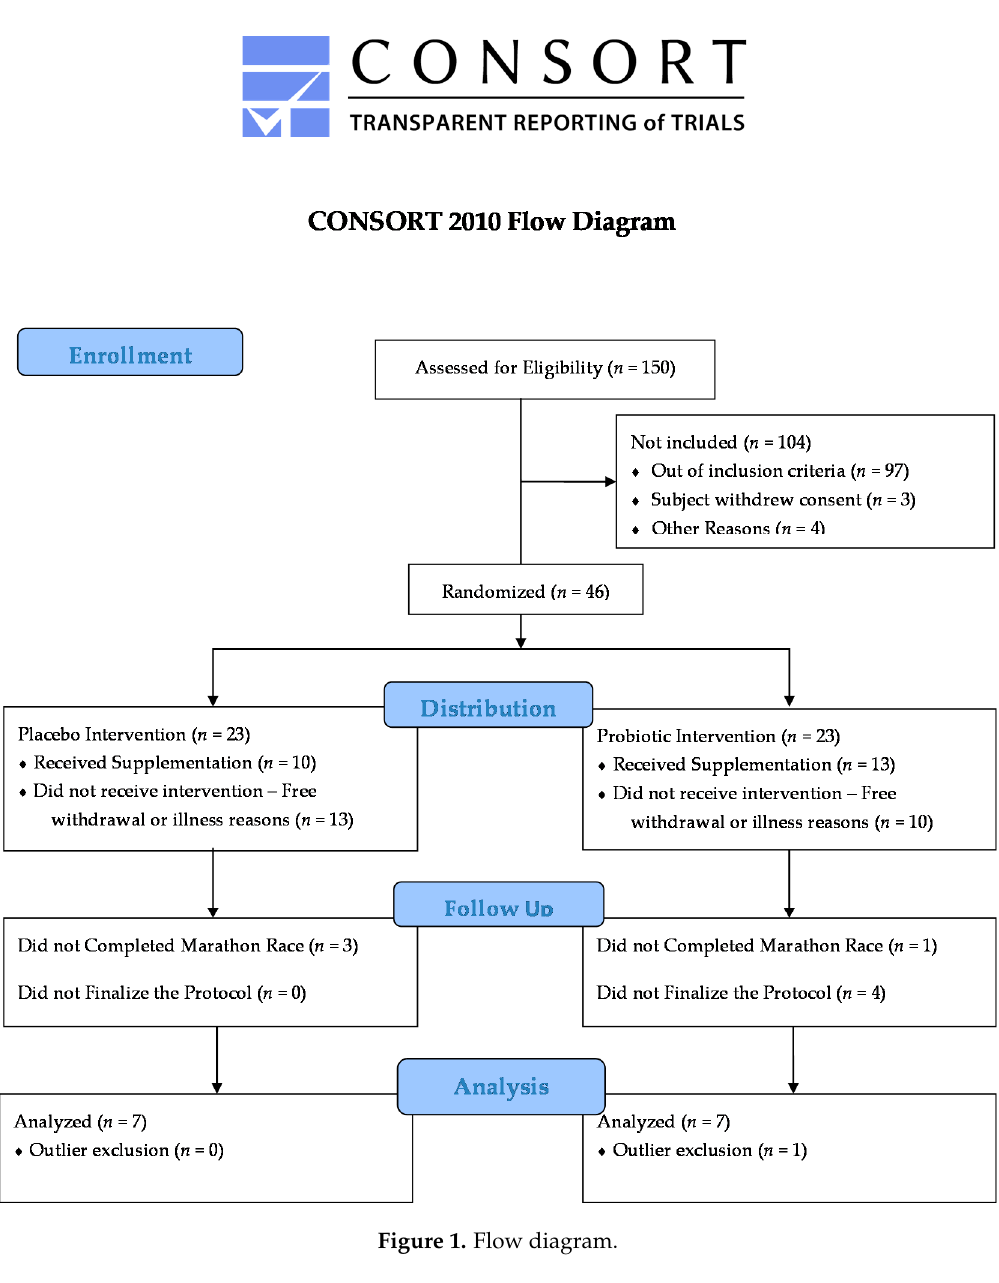
Figure 1. Flow diagram.